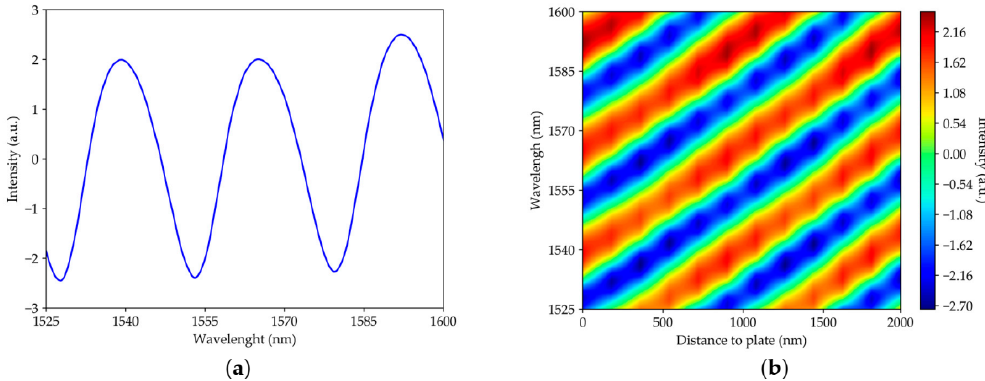
Figure 4. The single interferometer with a length of 73 ± 2 µ m: ( a ) Spectrum at the beginning of measurements and ( b ) intensity as a function of the distance between the optical fiber and the reflecting surface and as a function of wavelength.